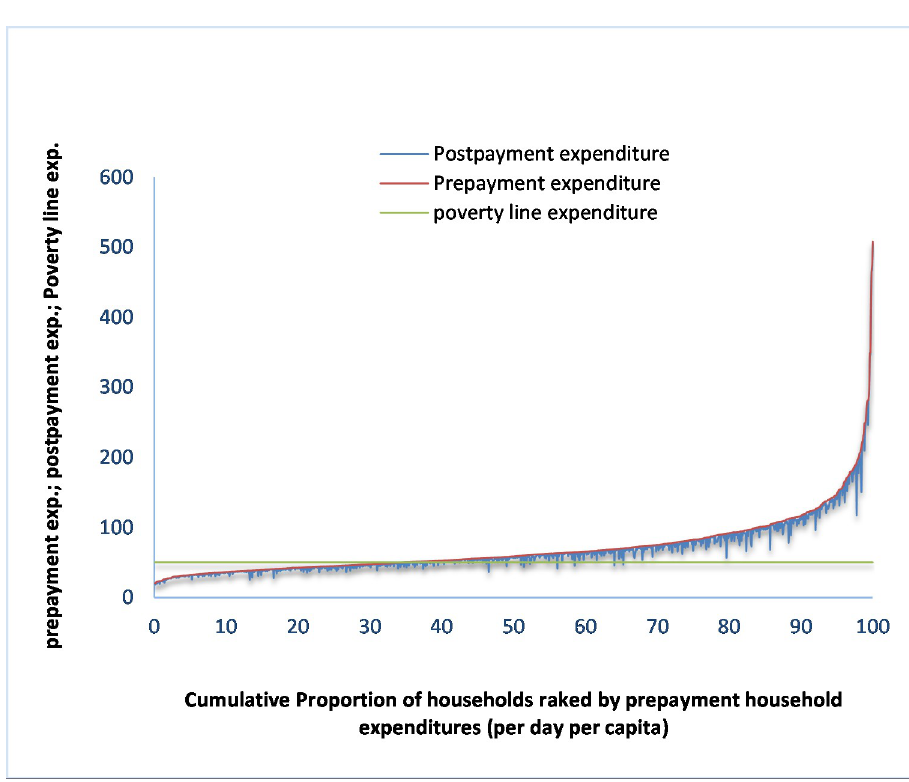
Fig 2. Poverty Pen’s parade graph for all ailments in HDP areas. https://doi.org/10.1371/journal.pone.0252706.g002 PLOS ONE | https://doi.org/10.1371/journal.pone.0252706 June 4,